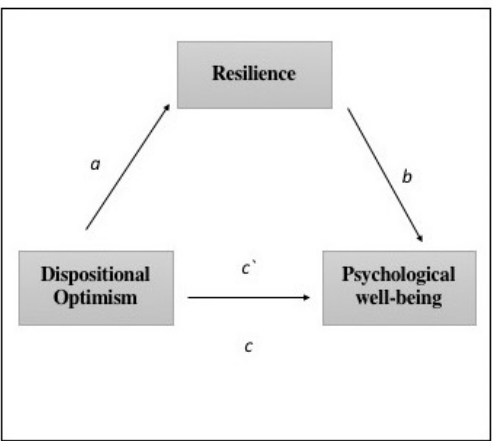
Figure 1. The conceptual and statistical scheme of the resilience mediation between dispositional optimism and psychological well-being (parameter (c’) is the direct effect of Dispositional Optimism (X) on Psychological well-being (Y) controlling for the mediating variable, (a) is the direct effect of X on M, (b) is the direct effect of M on Y, and the total effect (c) is the sum of the direct and indirect effects, the in which mediator is excluded from the regression).